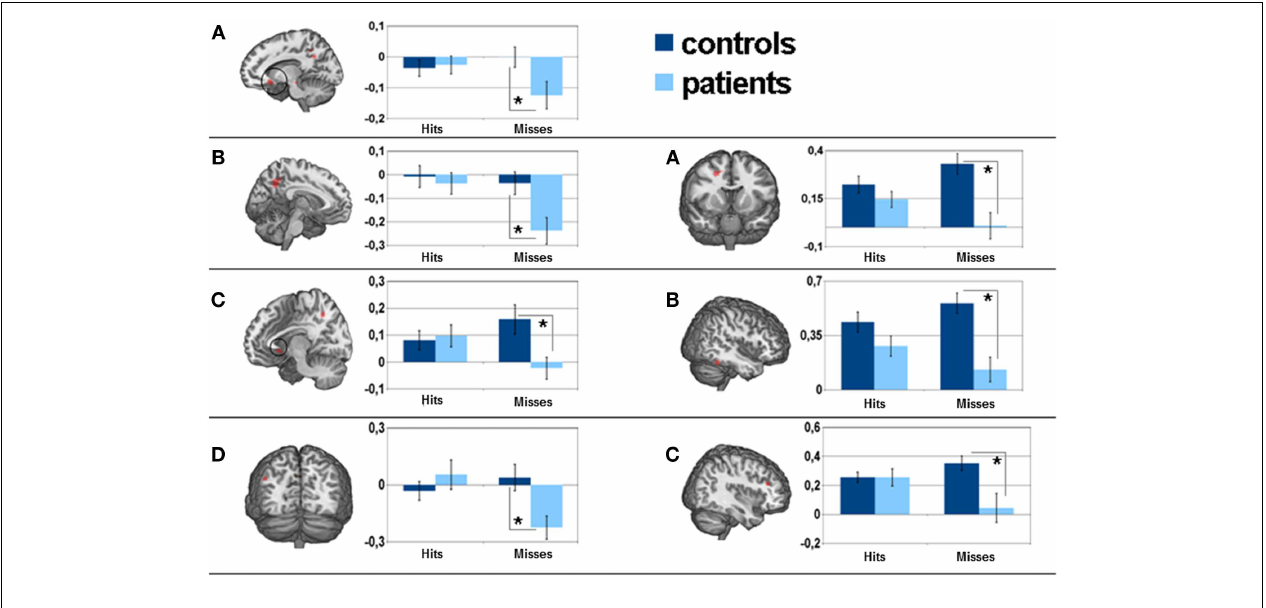
corresponding 5 mm sphere mean activity for separate factors: (A) right middle frontal gyrus, (B) right inferior temporal cortex, (C) right dorsolateral prefrontal cortex. *is considered significant at (A) p = 0.025, (B) p = 0.005, (C) p = 0.008, (D) p = 0.006, respectively (A) p = 0.001. (B) p = 0.00, (C) p =